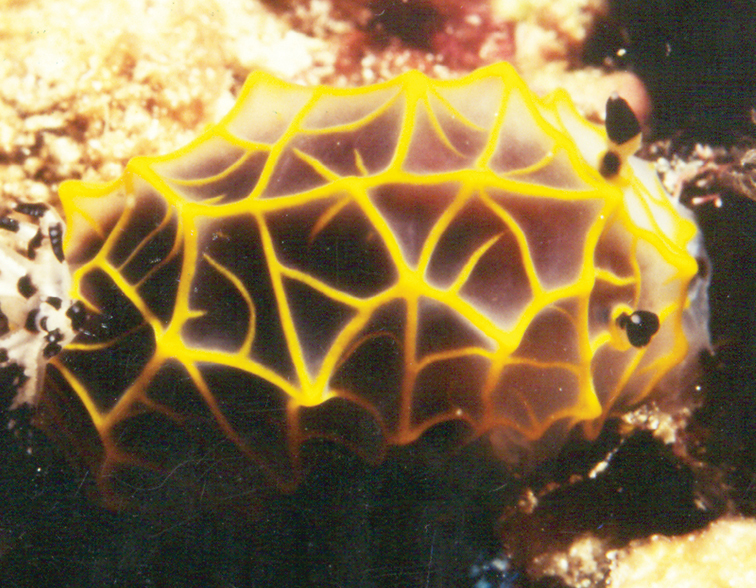
Halgerda formosa, Kenya, photo: MD Richmond (no spcm).